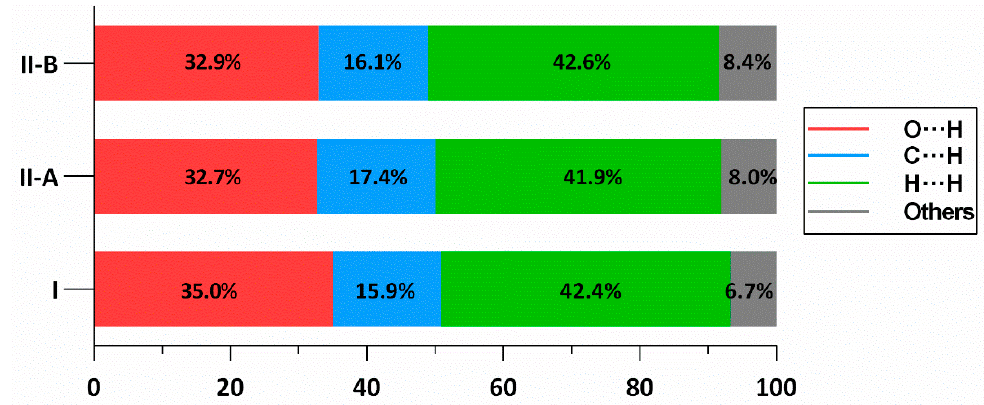
Figure 6. Relative contribution ratios of each type of contacts within the structure of I , and two parts of II (denoted as II - A and II -B), showing that the presence of water molecules in II raises the collective contribution of O ∙∙∙ H/H ∙∙∙ O amongst these interactions.